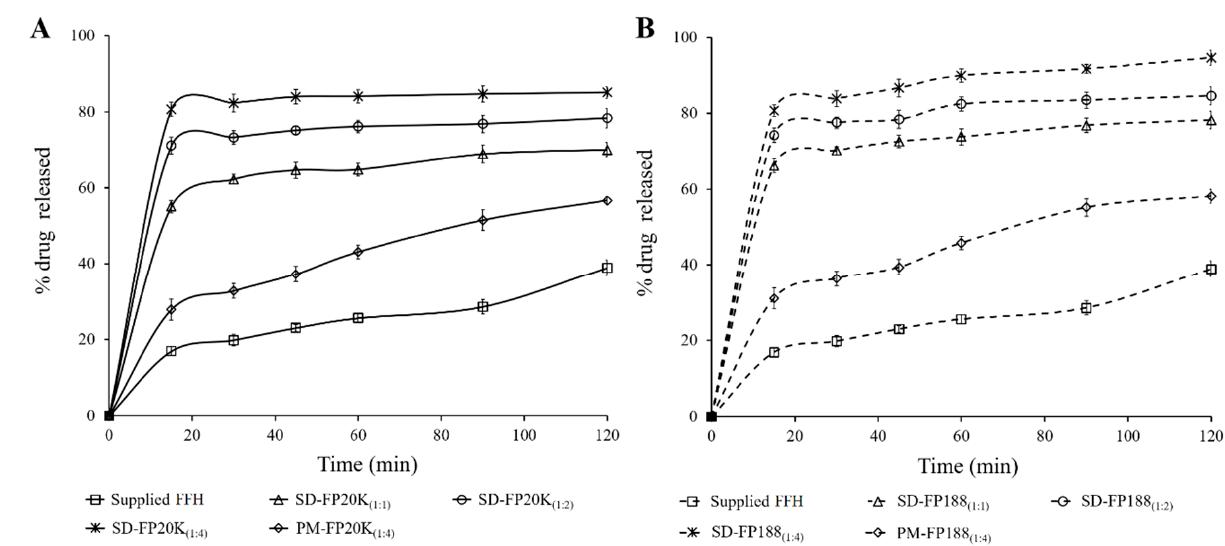
Figure 1. ( A ) In vitro dissolution profiles of supplied FFH, solid dispersions of FFH with PEG 20,000 at 1:1 (SD-FP20K (1:1) ), 1:2 (SD-FP20K (1:2) ) and 1:4 (SD-FP20K (1:4) ) weight ratios, and physical mixture of FFH with PEG 20,000 at 1:4 weight ratio (PM-FP20K (1:4) ). ( B ) In vitro dissolution profiles of supplied FFH, solid dispersions of FFH with poloxamer 188 at 1:1 (SD-FP188 (1:1) ), 1:2 (SD-FP188 (1:2) ) and 1:4 (SD-FP188 (1:4) ) weight ratios, and physical mixture of FFH with PEG 20,000 at 1:4 weight ratio (PM-FP188 (1:4) ) Each point represents the mean ± SD. ( n = 3). Table 2. Summary of dissolution parameters for supplied fexofenadine hydrochloride, solid disper- sions and physical mixtures prepared using PEG 20,000 and poloxamer 188.